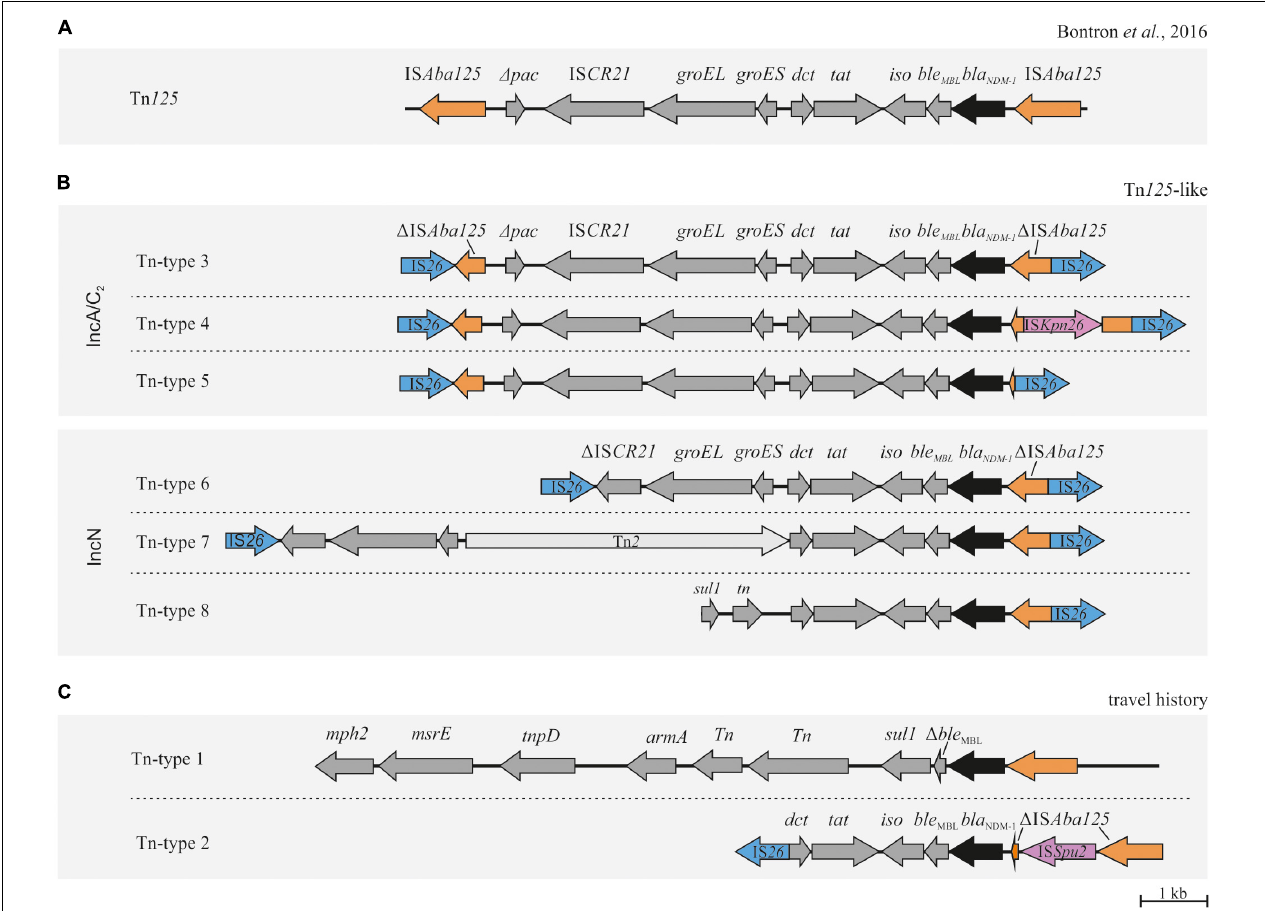
FIGURE 4 | Genetic organizations of bla NDM - 1 associated Tn 125 composite transposons. (A) Structure of the genuine Tn 125 composite transposon originally described by Bontron et al. (2016). (B) Organization of Tn 125- like structures in plasmids potentially involved in horizontal transmission. The complete reconstruction of pCF105-T8 failed (Tn-type 8). (C) bla NDM - 1 associated structures from isolates of patients with travel history demonstrating a different Tn structure. ORFs and respective orientations are represented by arrows. IS 26 elements are indicated in blue, IS Aba125 and (cid:49) IS Aba125 in orange, bla NDM - 1 in black and other ORFs in dark